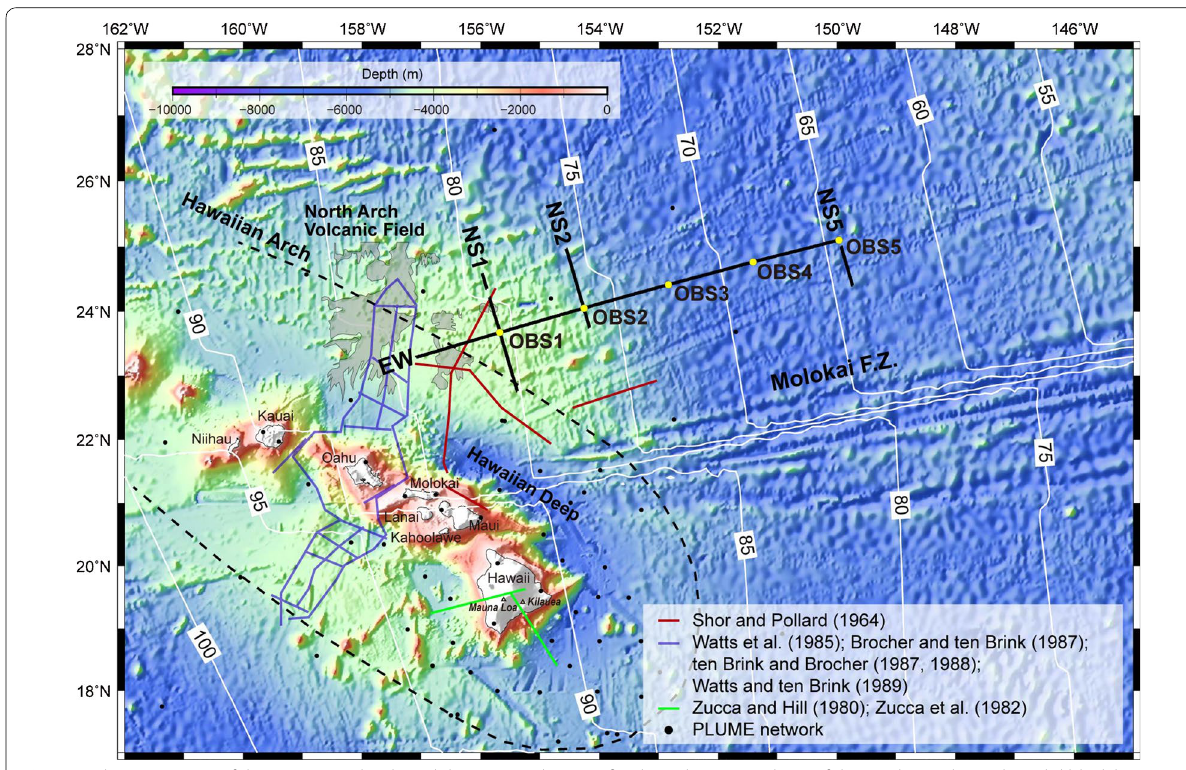
Fig. 1 Bathymetric map of the Hawaiian Islands and the surrounding Pacific Plate. The seismic lines of this study are shown by solid black lines, and yellow circles show the positions of ocean-bottom seismometers (OBSs). Colored lines show the locations of previous active-source seismic surveys around the island chain. Hawaiian Plume-Lithosphere Undersea Melt Experiment (PLUME) station locations are shown by black dots (e.g., Wolfe et al. 2009; Leahy et al. 2010; Laske et al. 2011). Thin white lines indicate seafloor age (in millions of years; from Muller et al. 2008). The black dashed line indicates the axis of the Hawaiian Arch (e.g., Holcomb and Robinson 2004; Ballmer et al. 2011). The North Arch volcanic field, characterized by strong acoustic reflectivity (Normark et al. 1989; Clague et al. 1990, 2002), is indicated by gray